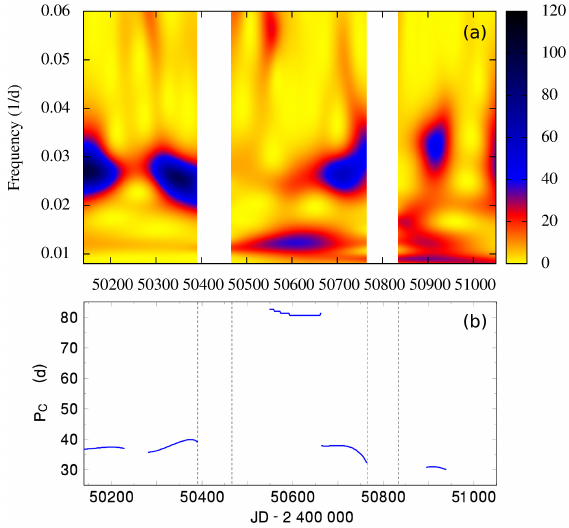
Figure 2: (a) WWZ-transform of the moving averages of KS 1731–260 from Fig. 1a. (b) The best cycle-length. See Sect. 3 for details. Adapted from